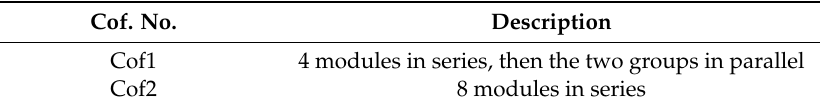
Table 7. Different types of TE module configurations for